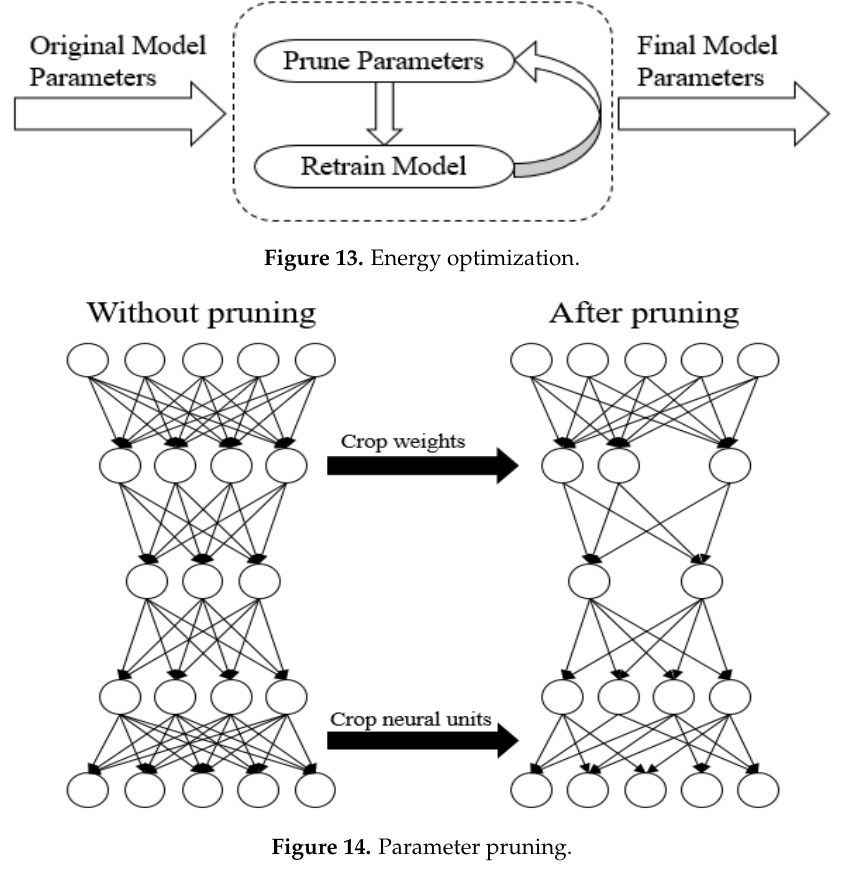
Figure 14. Parameter pruning.